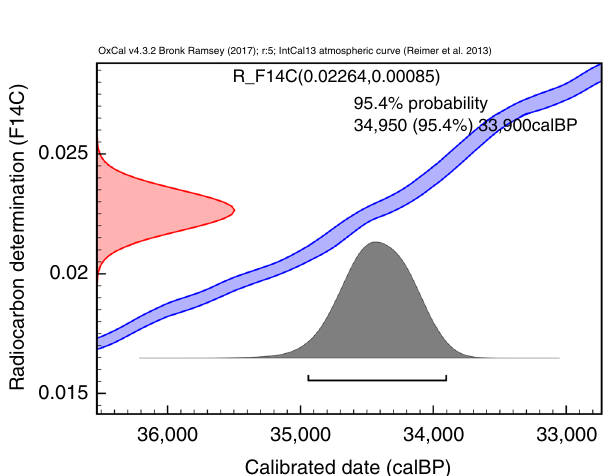
Fig. 3 Calibration of the radiocarbon measurement. The left-hand axis shows the radiocarbon concentration (F 14 C or fraction modern) and the bottom axis shows the calibrated age obtained using the IntCal13 calibration curve of Reimer et al. 25 . Figure produced using OxCal